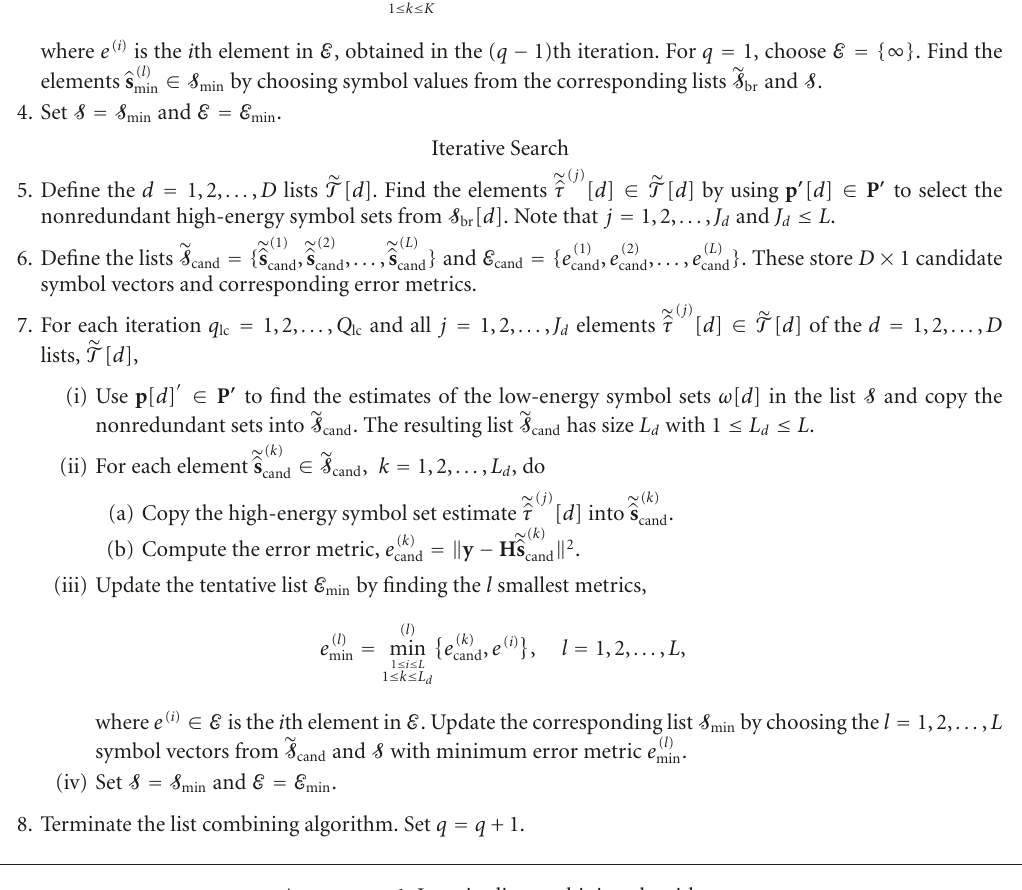
Algorithm 1: Iterative list combining